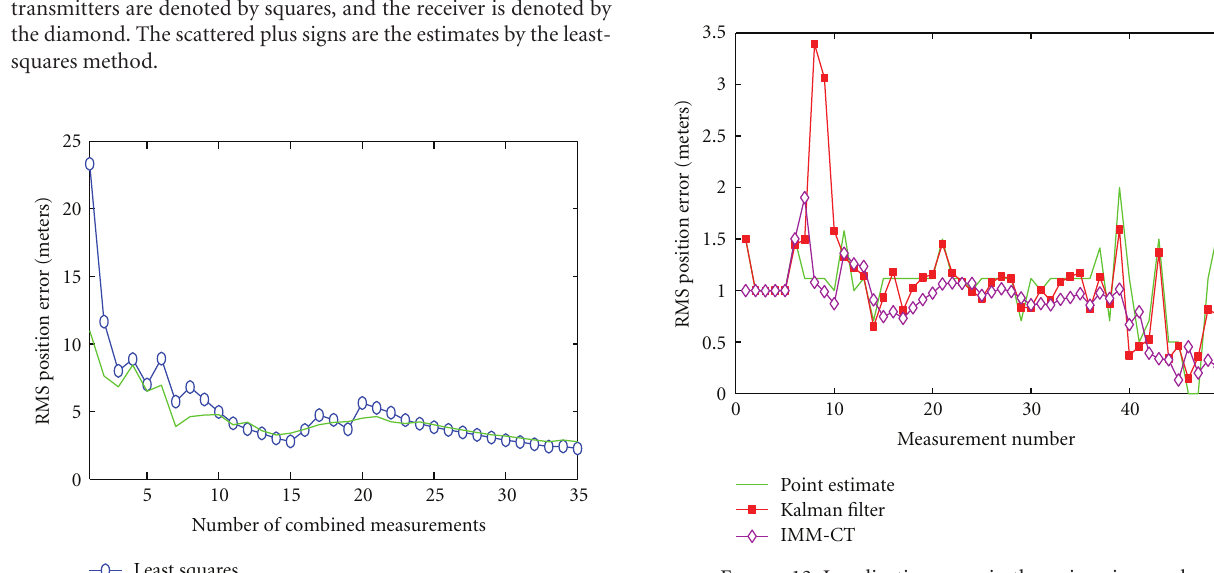
Figure 13: Localization error in the swimming